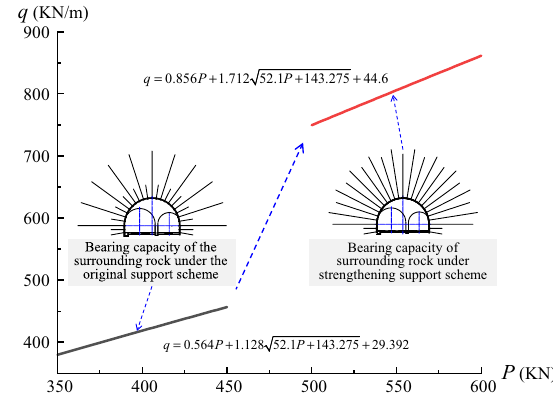
Fig. 18 Comparison of bearing capacity of compression arch under original and reinforced support